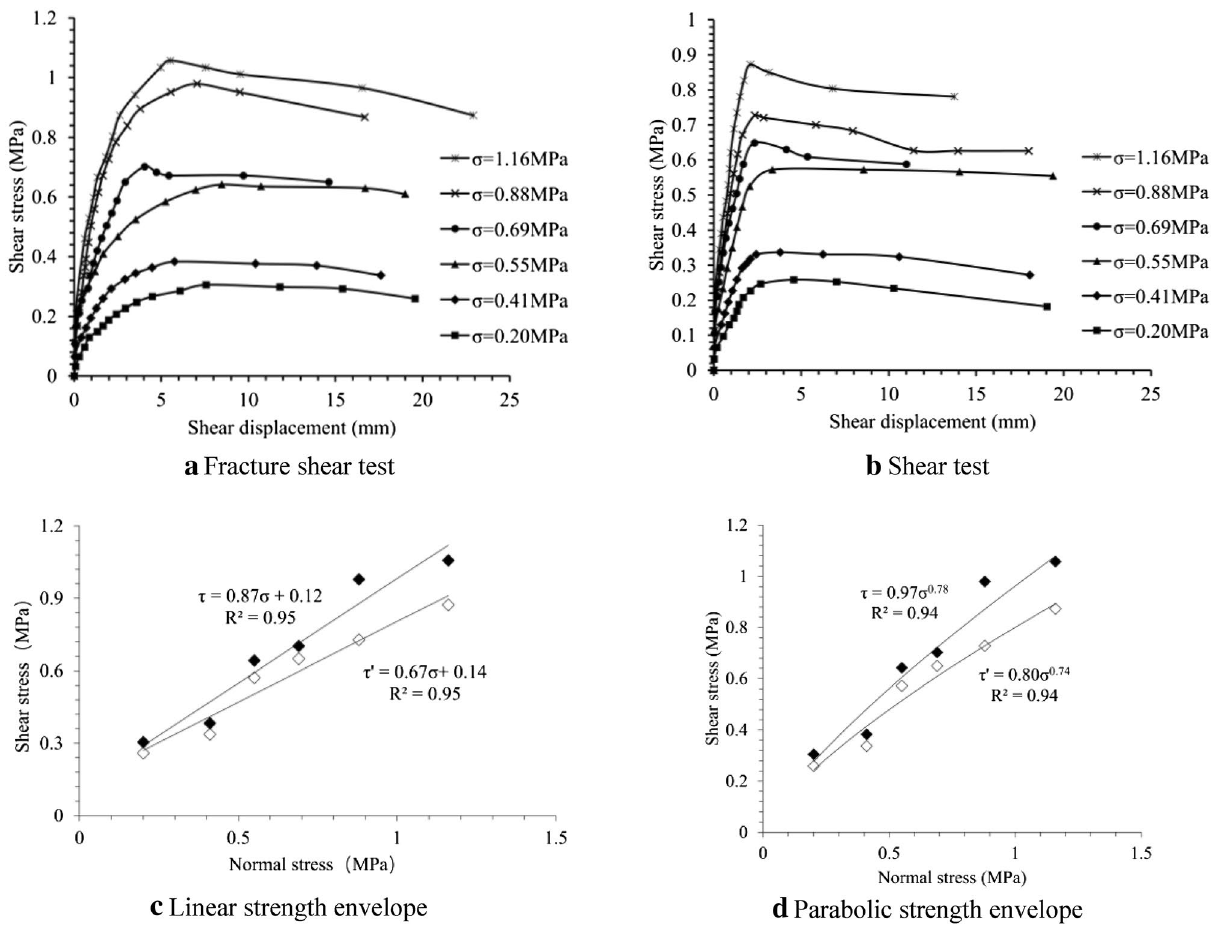
Figure 11. Shear normal stress and